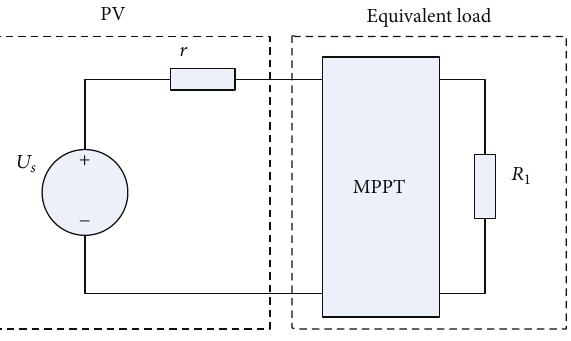
Figure 5: Equivalent model of PV and load. Figure 6: Process of tracking MPP.